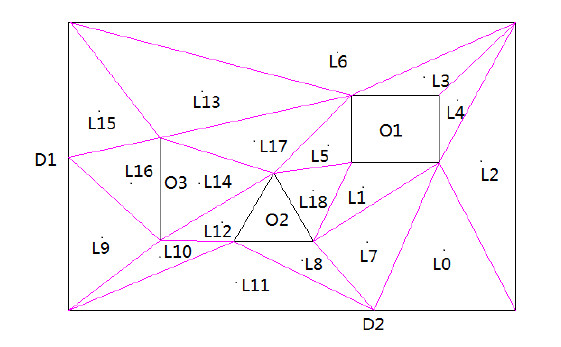
Figure 4. Area feature points